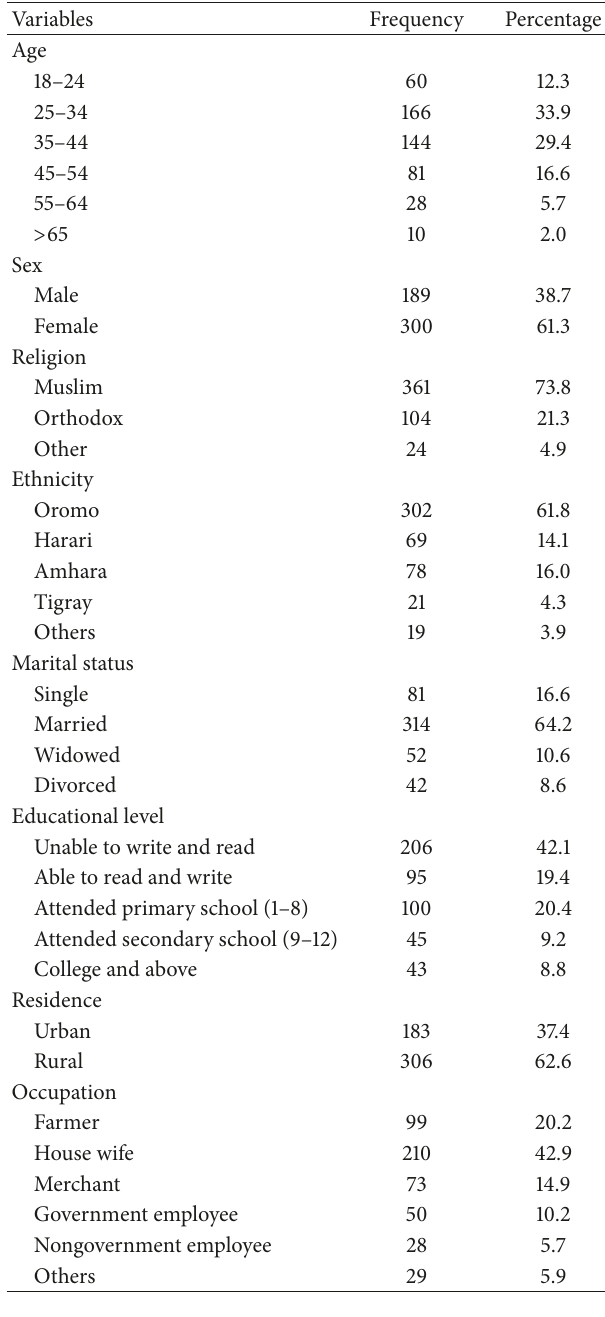
Table 1: Sociodemographic characteristics of respondents on depression and associated factors among adult inpatients in Harari region hospitals, Eastern Ethiopia, 2017 ( 𝑛 = 489